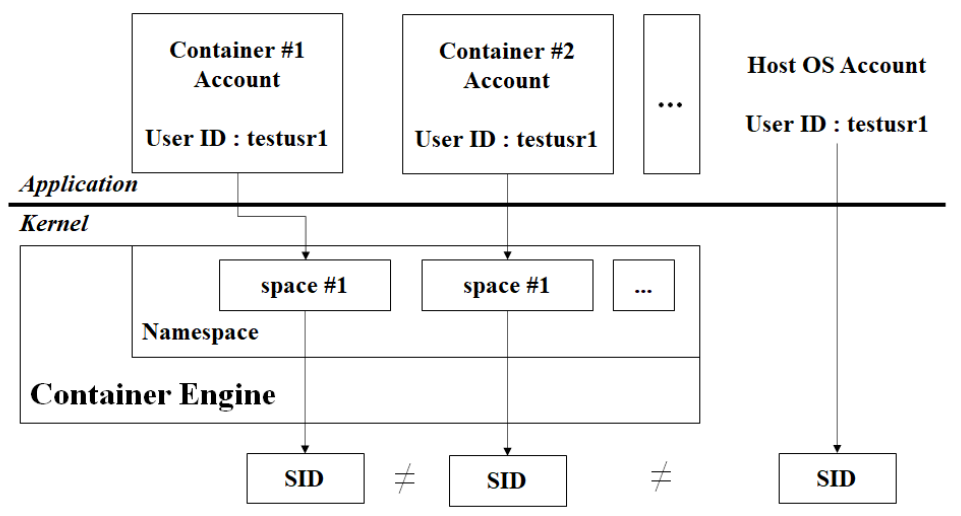
Figure 3. Scenario in which the same account may exist at multiple positions in the container platform.